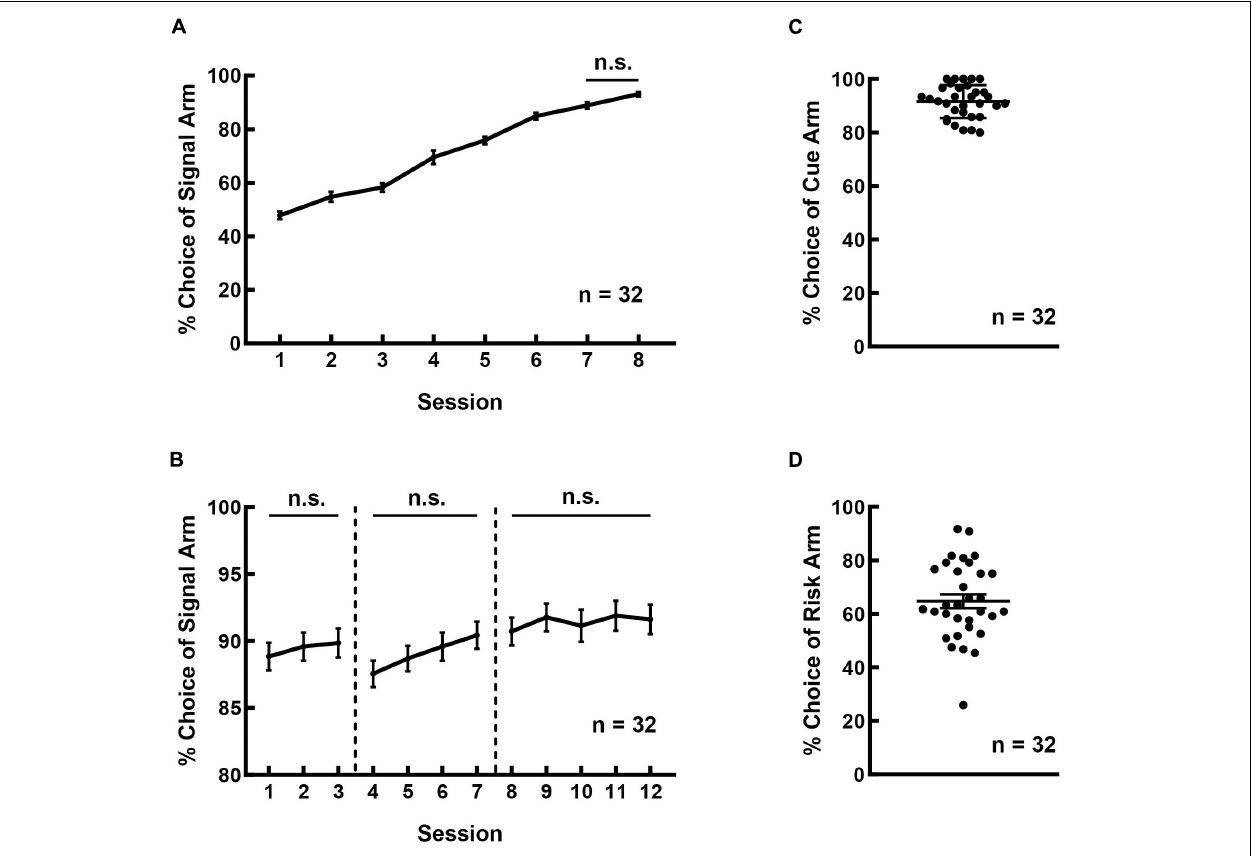
FIGURE 2 | Rats could learn the cue-guided RDM task and showed a preference for the risk option. (A) The learning curve of the rats during the signal-learning stage. (B) The learning curve of the rats during the cue-reinforcement stage. The safe-cue reinforcement, risk-cue reinforcement, and random reinforcement phases are separated by the dotted vertical lines. (C) The frequency of choosing a cued arm in the cue-test blocks was higher than 80%. (D) A majority of rats exhibited preference for the risk arm in the free-choice